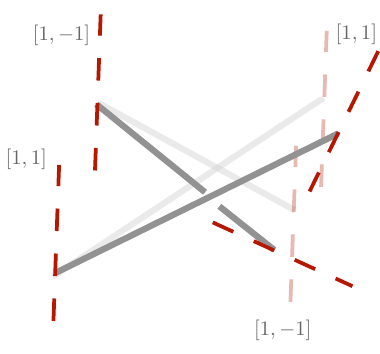
Figure 6 . Recombined configuration neglecting brane interactions. Fixing the boundary condi- tions, that is the positions of the 7-branes, the minimal energy configurations are straight lines, as